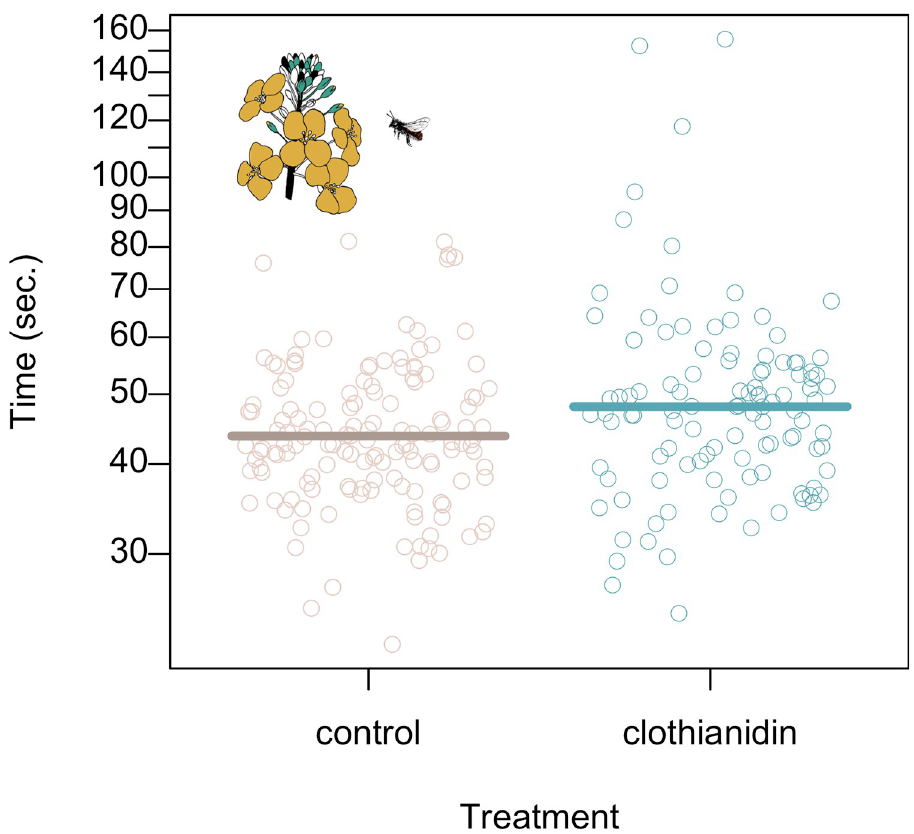
Fig 4. Bees foraging from rapeseed that had been seed-coated with clothianidin used more time to visit ten rapeseed flowers. Dots show raw data and lines show back-transformed posterior means. Exclusion of three outliers had no impact on the result (Table